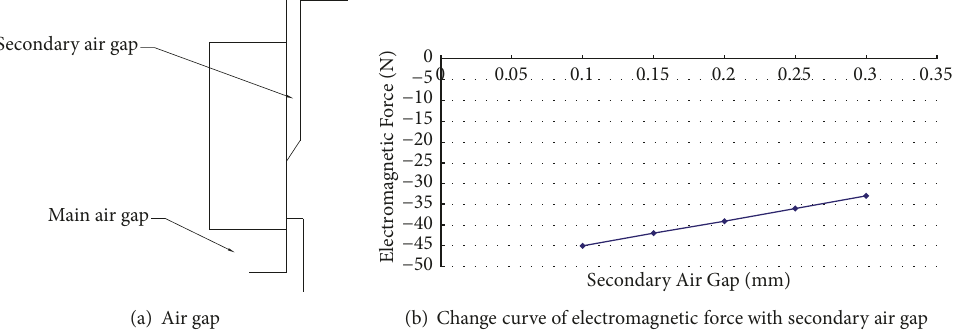
Figure 8: The secondary air gap and its effect on electromagnet force.